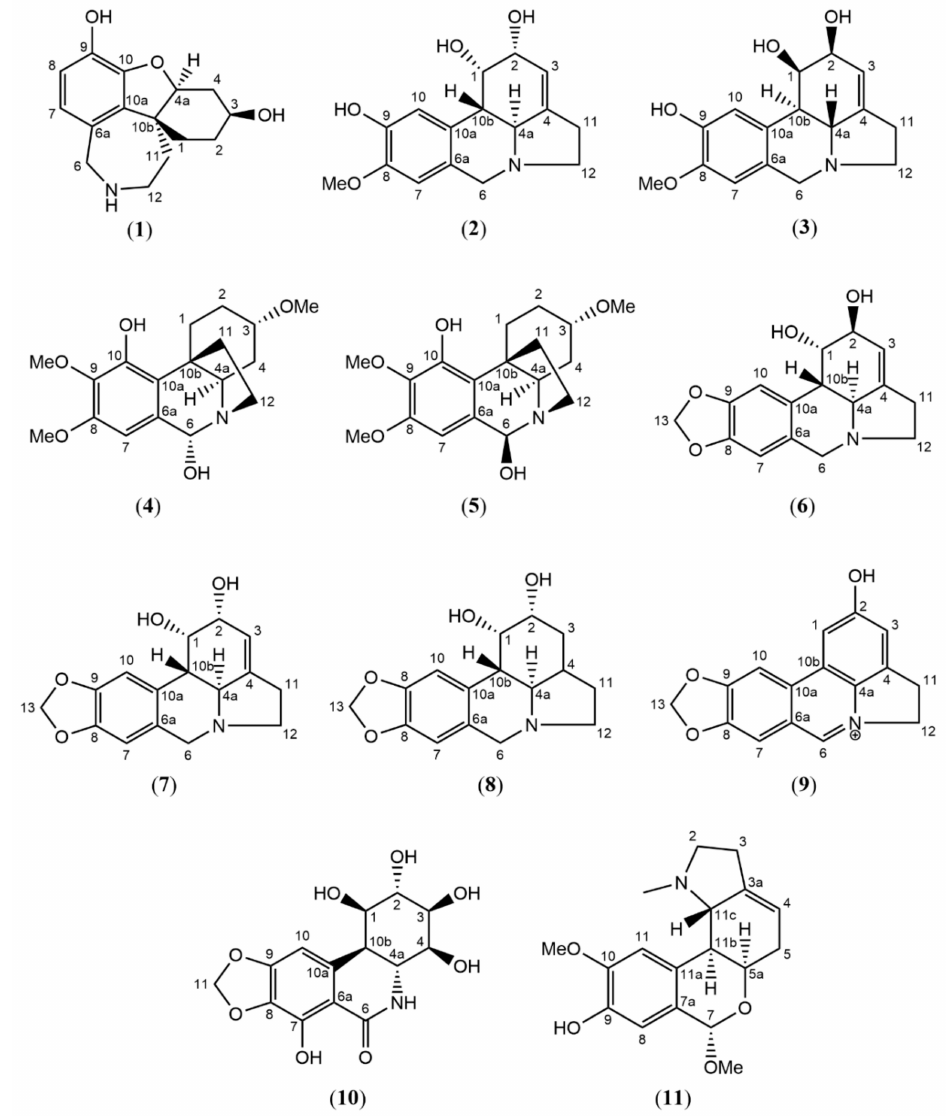
Figure 1. Structures of compounds 1 – 11 isolated from the bulbs of Hymenocallis littoralis